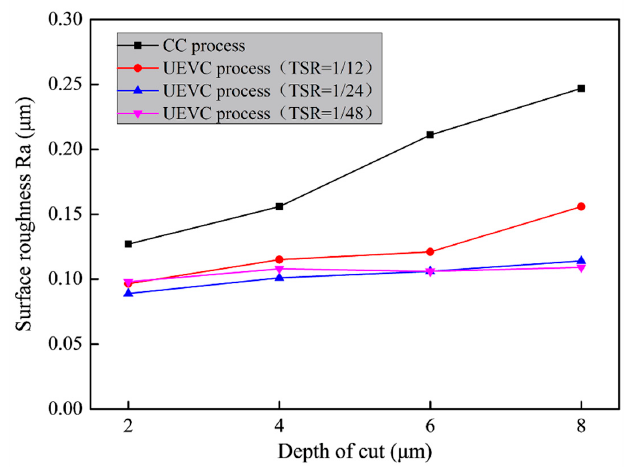
Figure 9. Influence of the predetermined depth of cut on the bottom surfaces roughness of the machined micro-grooves produced by different processing conditions.